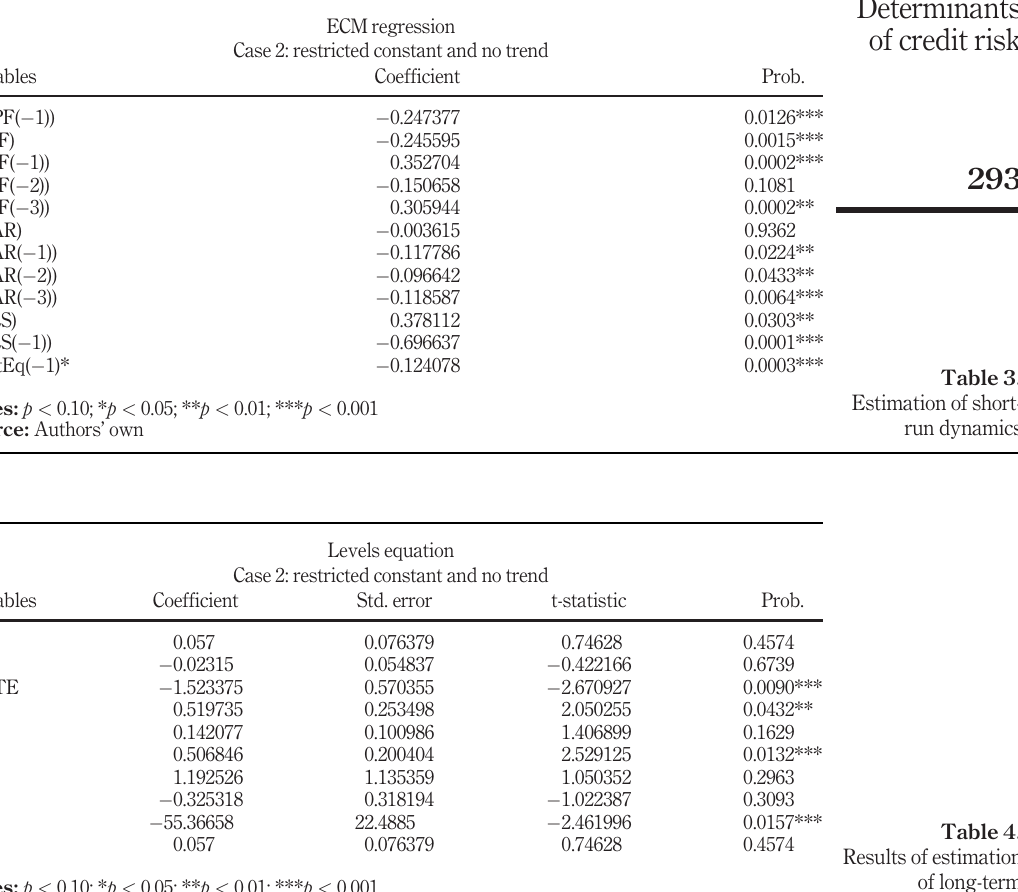
Table 4. Results of